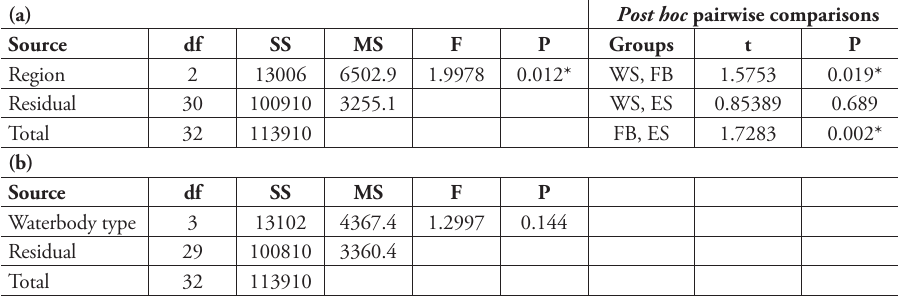
Table 4. Non-parametric permutational MANOVA (PERMANOVA) results for models comparing bee- tle assemblage composition. Assemblage composition at St Lucia was compared across (a) regions, and (b) waterbody types. The multivariate models tested for differences between group centroids in Bray-Curtis dissimilarity space. Pairwise comparisons are reported in the case of (a), where overall test results were significant. WS – Western Shores; FB – False Bay; ES – Eastern